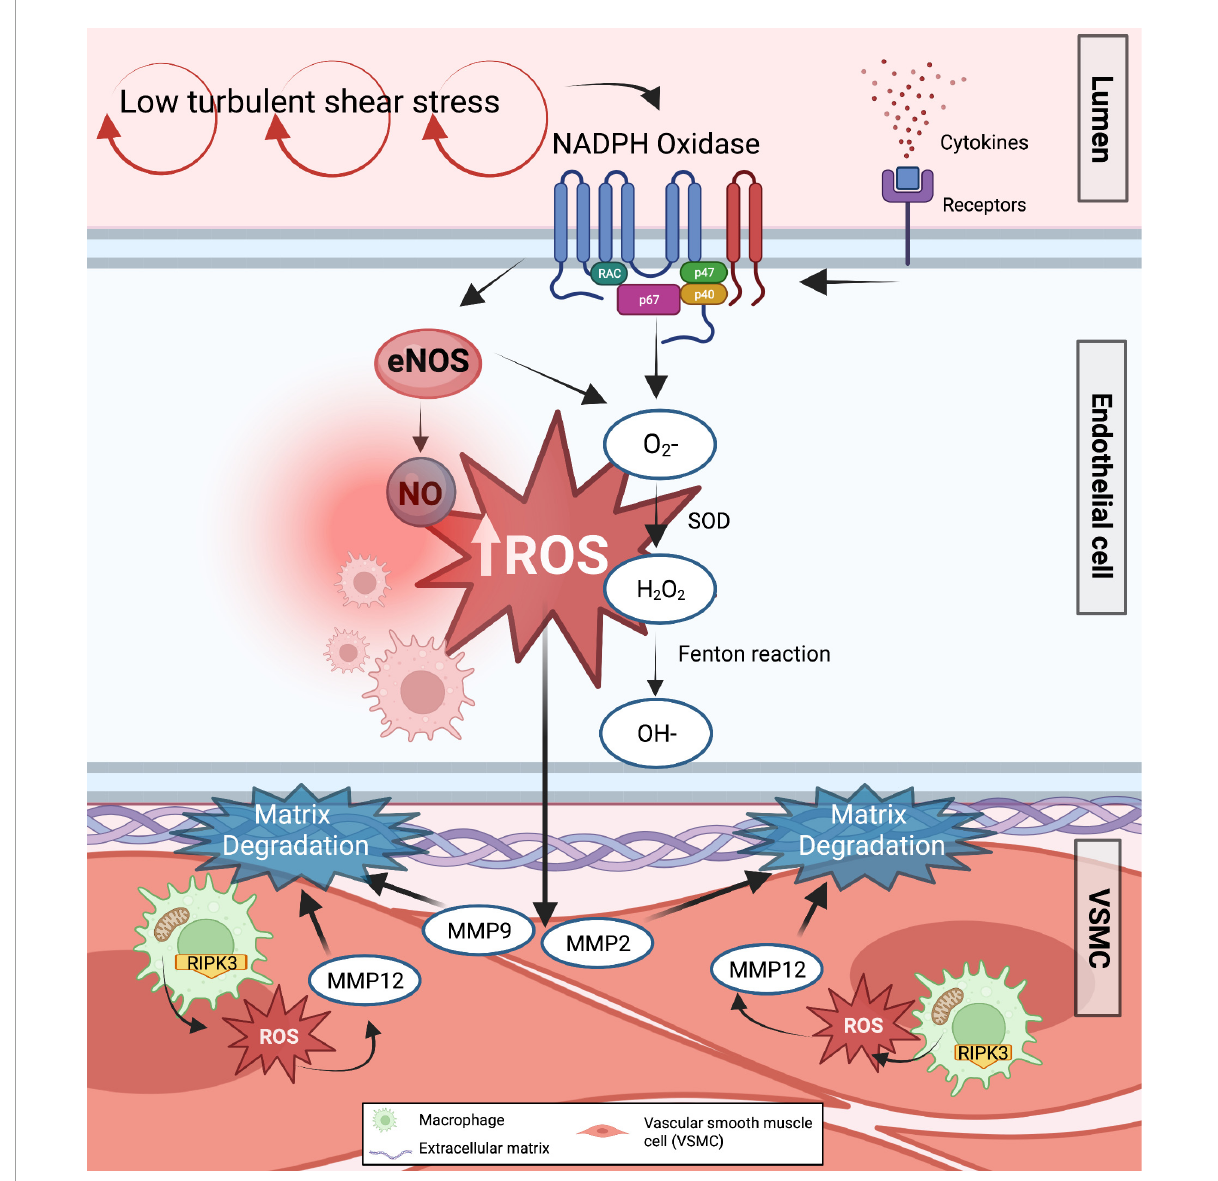
FIGURE3 Formation of ROS in response to low shear stress in AAA. The majority of ROS primary sources, such as uncoupled eNOS and NADPH oxidase, are known to enhance ROS generation in response to low shear stress. As a result, various ROS are generated in the endothelium cells. Increased O 2 - and H 2 O 2 inactivates endothelium-derived NO synthase and takes up any NO produced while augmenting the transcriptional factors involved in the activation of downstream effectors related to matrix degradation and inflammation. Furthermore, mitochondrial ROS are produced from pro-inflammatory aortic macrophages via RIPK3, further inducing matrix degradation and AAA